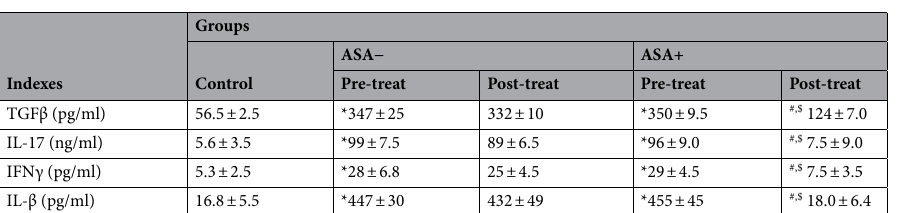
Figure 5 . A plot heatmap to show the gene expression profile of DEGs in both bioinformatics ( A ) and experimental data (−∆CT) ( B , C ). The green color indicates down-regulated genes, and the red indicates up-regulated genes between tumor and normal samples.